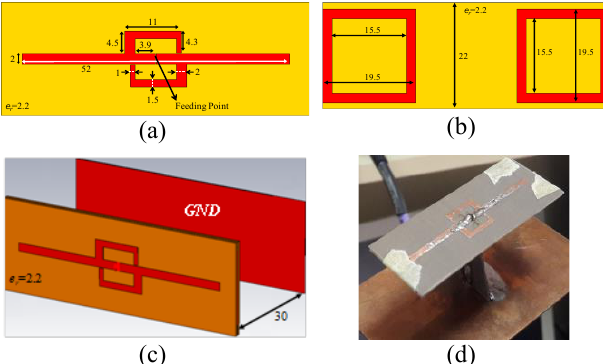
Figure 1: The proposed wideband MDA design a) top layer b) bottom layer c) perspective view d) fabricated (all dimensions are in mm).